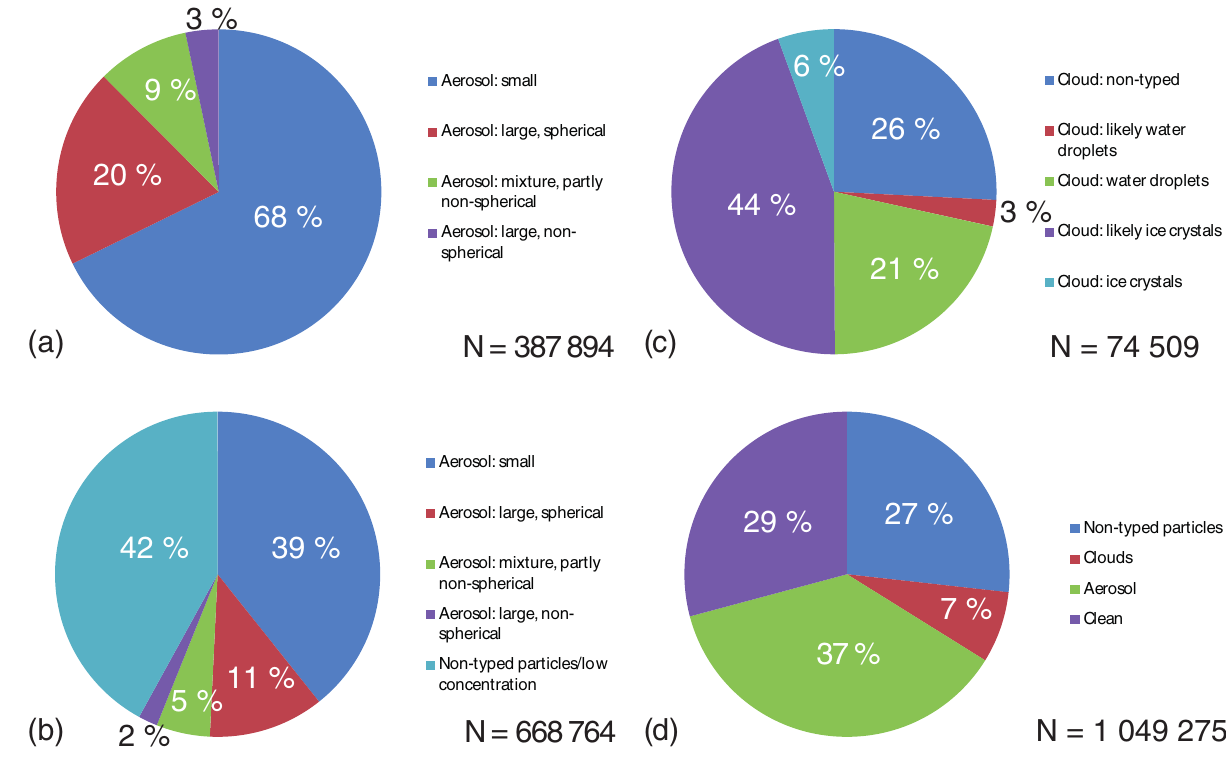
Figure 15. Statistics on particle categorization for the entire HOPE campaign: (a) for all typed aerosol particles, (b) typed aerosol and non-typed particles, (c) cloud particles, and (d) all typed